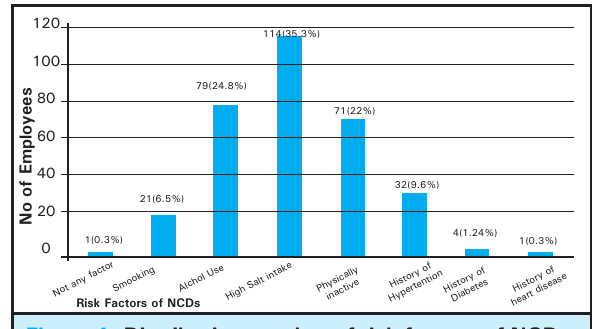
Figure 1. Distribution number of risk factors of NCDs: not any factor, smoking, alcohol use, high salt intake, physically inactive and history of high blood pressure, diabetes and heart disease among government employees.